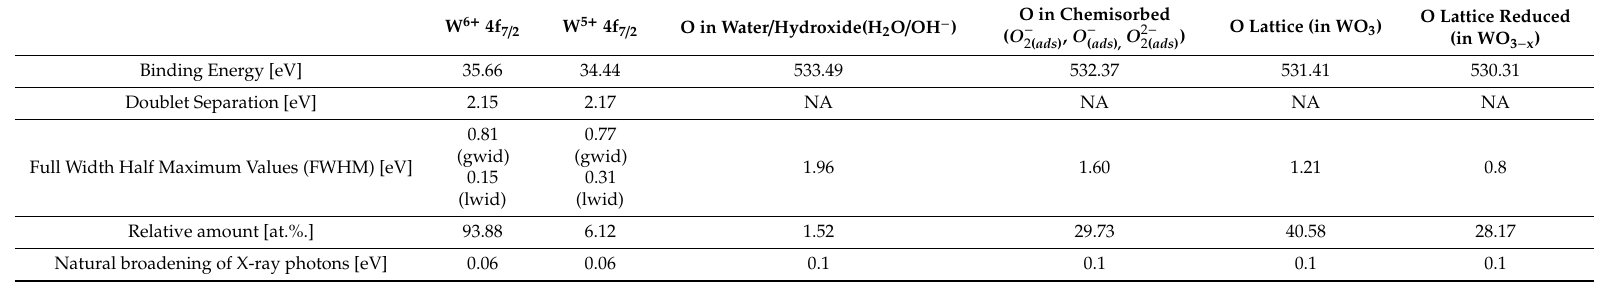
Table 1. Low dose synchrotron analysis of O and W positions from WO 3 thin